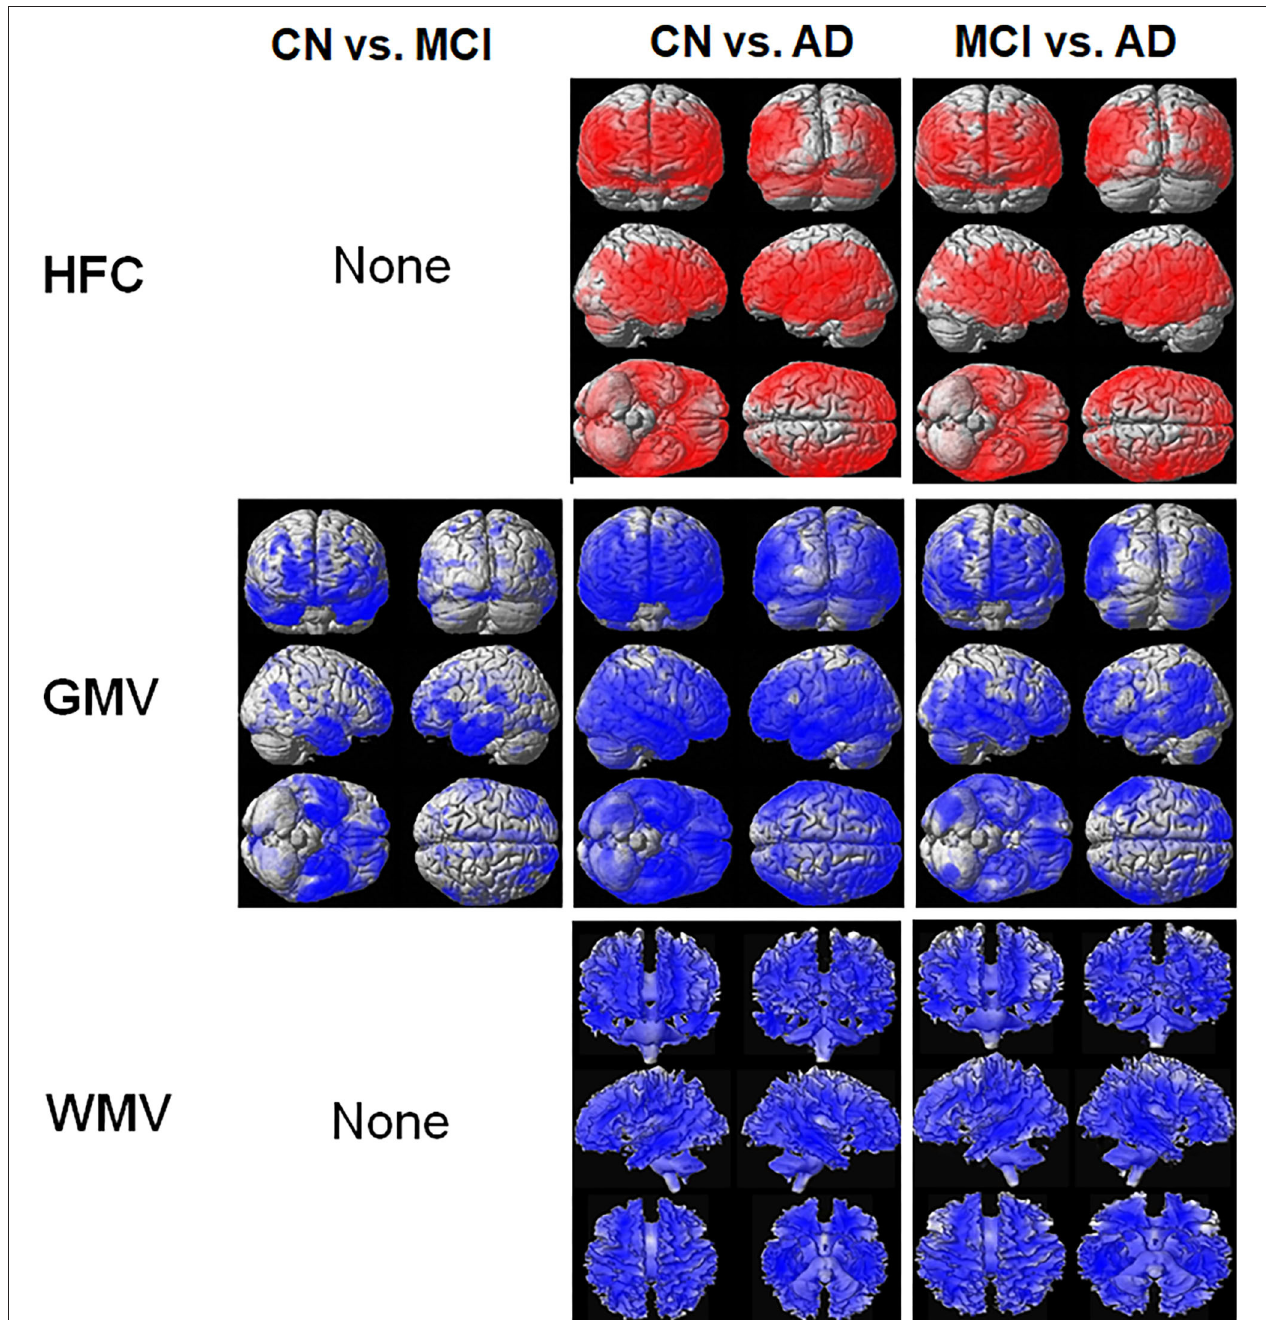
FIGURE 2 | Result of the voxel-based analysis of covariance (ANCOVA) analysis of the HFC and brain tissue maps between the three participant groups. The red color indicates the results of CN < MCI, CN < AD, and MCI < AD and the blue color indicates the results of CN > MCI, CN > AD, and MCI > AD. Details of the significantly different locations in the brain are listed in Supplementary Table 1 for HFC, Supplementary Table 2 for gray matter volume (GMV), and Supplementary Table 3 for white matter volume (WMV).